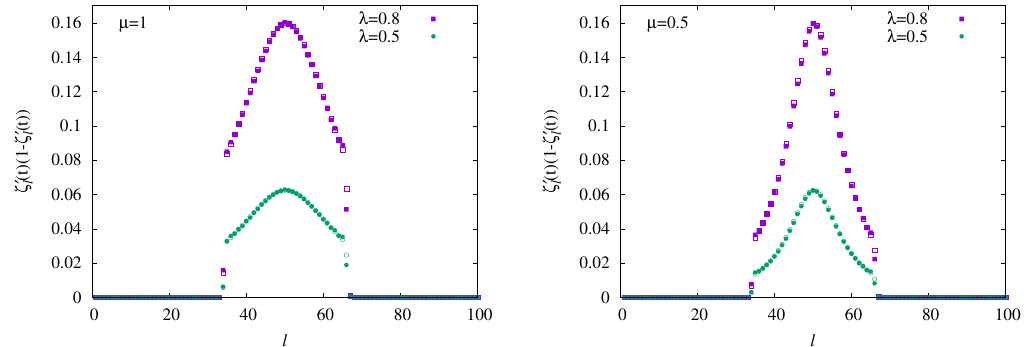
Figure 5: Numerical check of the relation (54), with the left / right hand side of the equation shown by the full / empty symbols, for L = 100, t = 50 and two different values of µ